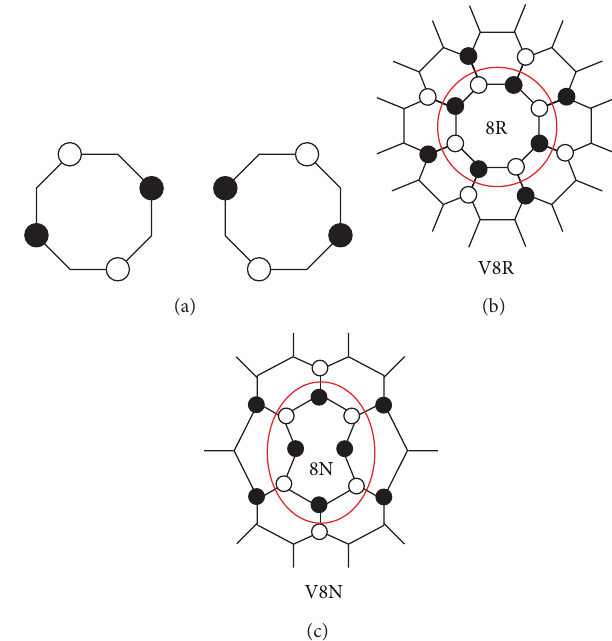
Figure 4: (a) Two possible representations of the zero-energy TB wavefunctions for the octagonal carbon ring. Filled and empty circles mean positive and negative values of the wavefunction; no circle means that the wavefunction is exactly zero. (b), (c) Schematic views showing how the 8R and 8N octagons are connected to the voids V8R and V8N, respectively. Filled and empty circles indicate the void-edge nodes corresponding to different